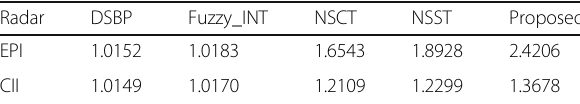
Table 2 Objective evaluation parameters for Barbara image set Barbara